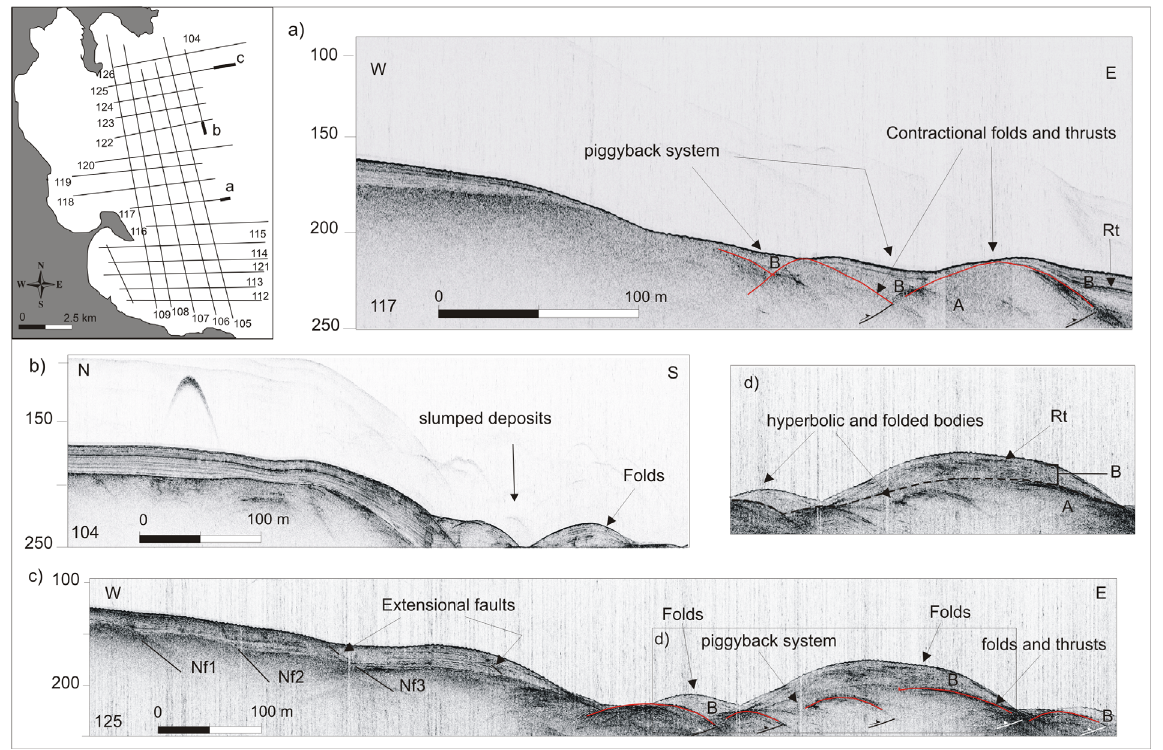
Figure 12. Chirp profiles showing slump accumulations (location of the sections is shown in the profile grid: thick lines. Depth in metres): a) in the south-central sector, close to the L2 fault, slumped masses are observed with contractional folds and thrusts at the toe forming a piggyback system ( sensu Alsop and Marco [2011]); B body filling the piggyback basins is folded and contains Rt reflector; b) deformation in the north-cen- tral sector at the foot of the C-s1 scarp; c) deformation in the northern sector at the foot of the Nf3 scarp; rectangle refers to the detail shown in d; d) detail of the two slumped bodies; please notice the extensional faults at the head of the body and folds at the toe; the lower body A shows more pronounced hyperbolas than the overlying body